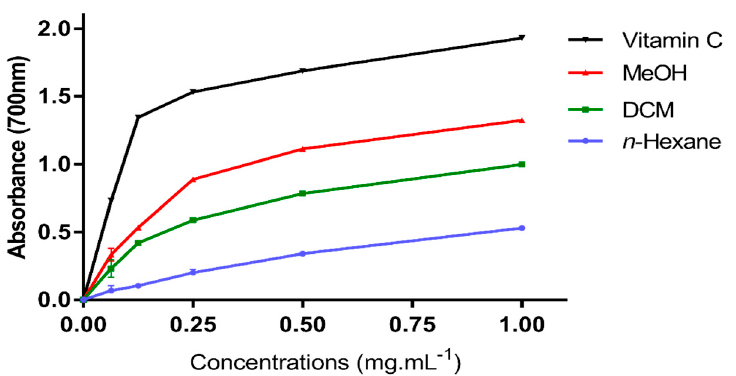
Figure 3. Ferric reducing antioxidant power (FRAP) assays ( n = 3) compared to vitamin C as standard; the differences were analyzed using Duncan and Tukey’s post hoc test for multiple comparisons with p < 0.05.